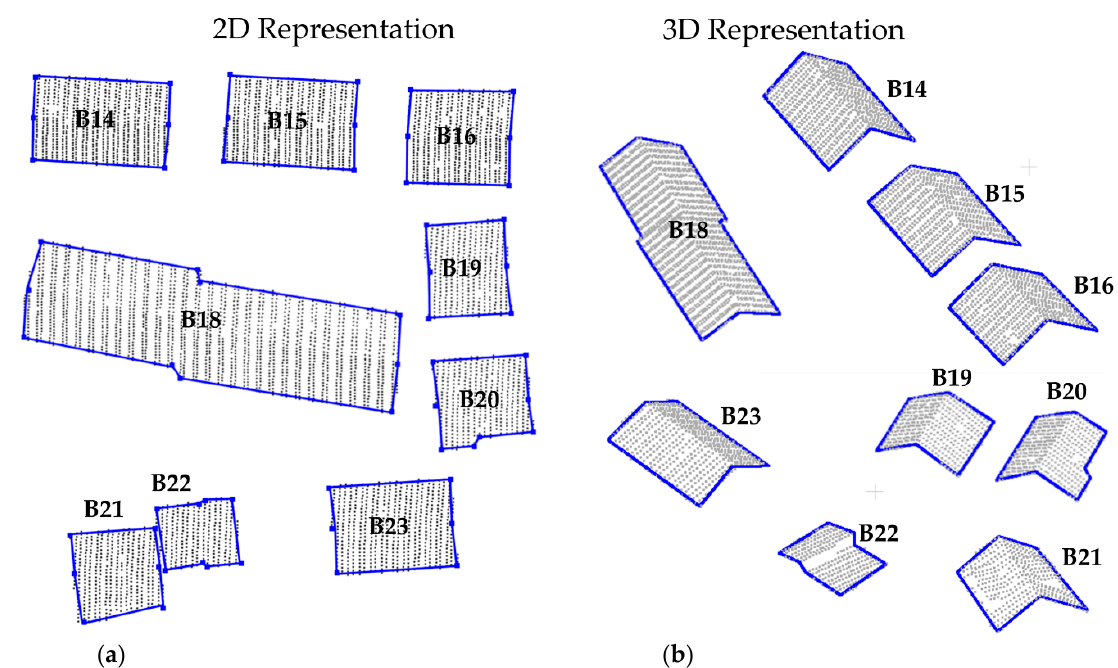
Figure 12. Vaihingen/Germany dataset. Building boundary regularization results derived from the proposed strategy. Boundaries and corner points (square blue) over roof points 2D ( a ) and 3D space ( b ).